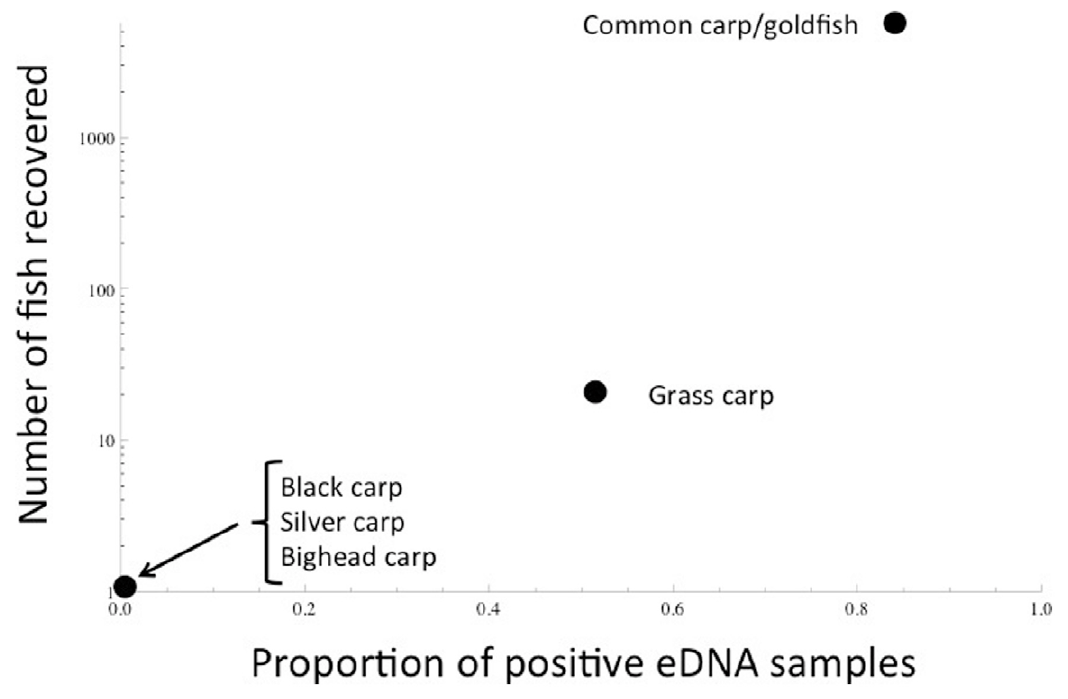
Figure 3. Relationship of detections using environmental DNA and the number of fish recovered in the 2010 rotenone effort.